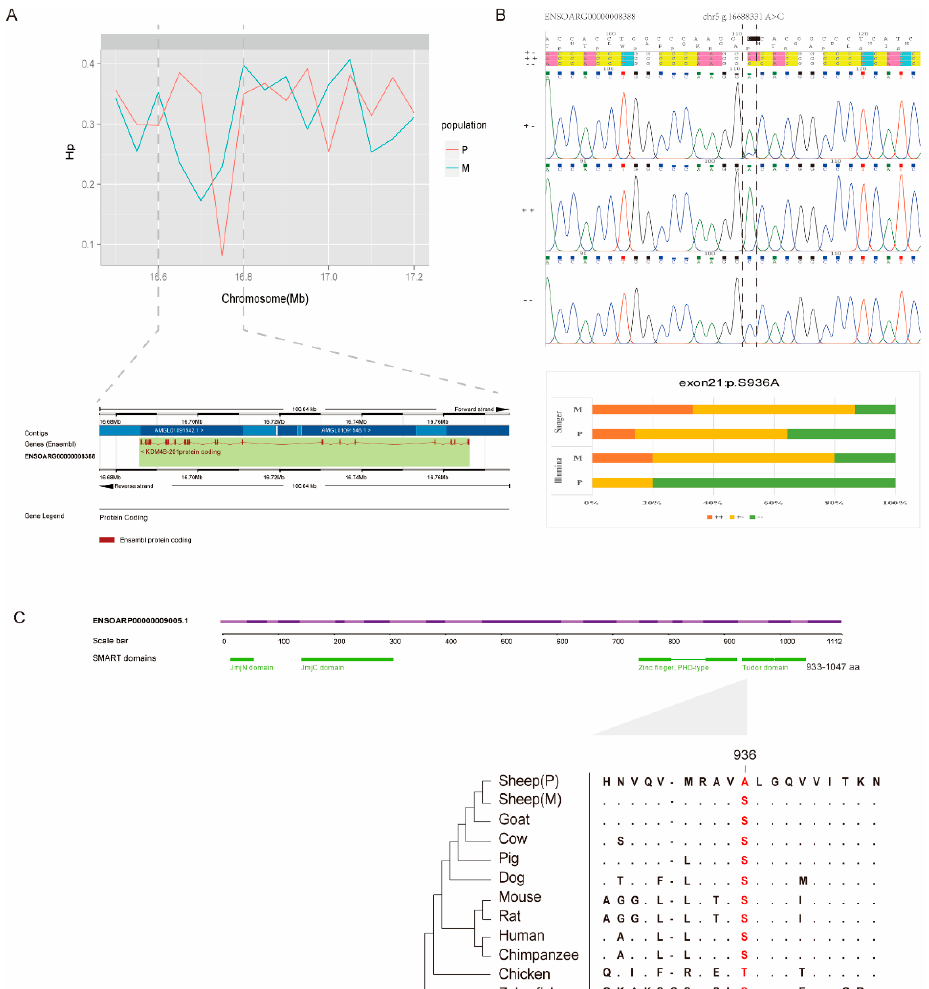
Figure 3. KDM4B mutation in the coding region. ( A ) Hp value around the KDM4B loci. Hp was calculated for each 10 kb window of the monotocous and polytocous sheep. The gene coordinates are based on Ensembl ID ENSOARG00000008388; ( B ) Percentages of homozygotes and heterozygotes in the monotocous and polytocous sheep. The reference and mutant alleles are represented by “+” and “ − ,” respectively. Besides the 10 sheep sequenced with Illumina technology, additional samples were genotyped by Sanger sequencing; ( C ) Evolutionary analysis of the p.S936A amino acid variant. The protein coordinates are based on Ensembl ID ENSOARP00000009005.1. The upper panel shows the domains of the protein. The orthologous protein sequences from 11 vertebrates are aligned with the mutant residues shown in red. The NJ tree derived from the multiple alignment is shown in the lower panel.